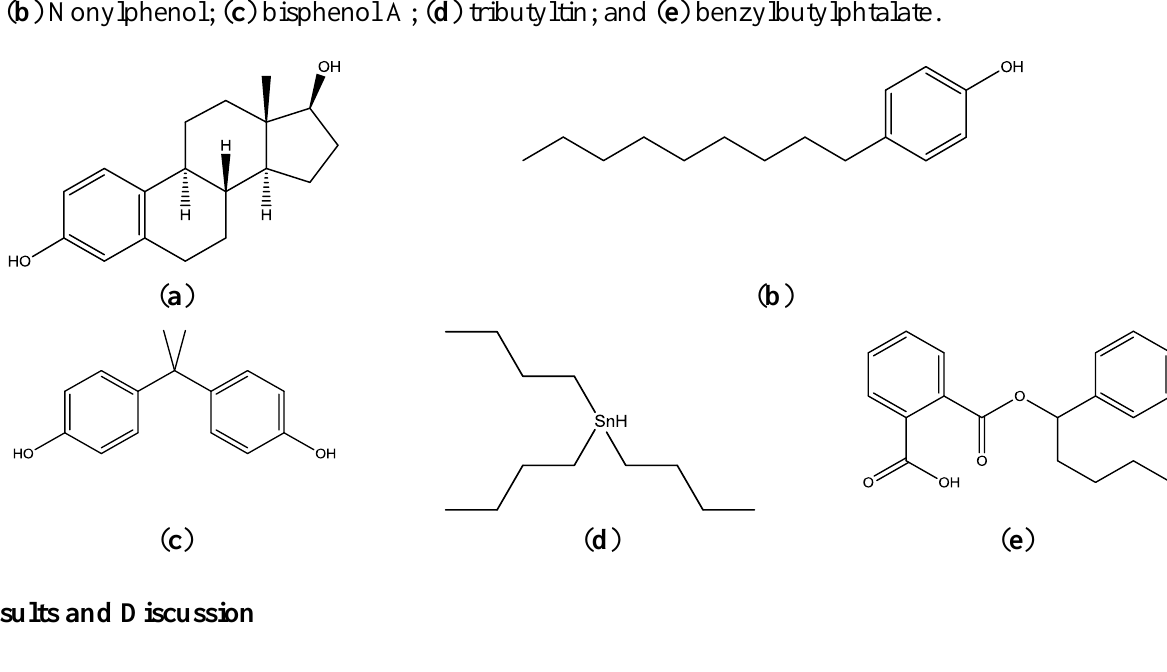
Figure 1. Chemical structure of natural hormone and EDCs. ( a ) Estradiol;